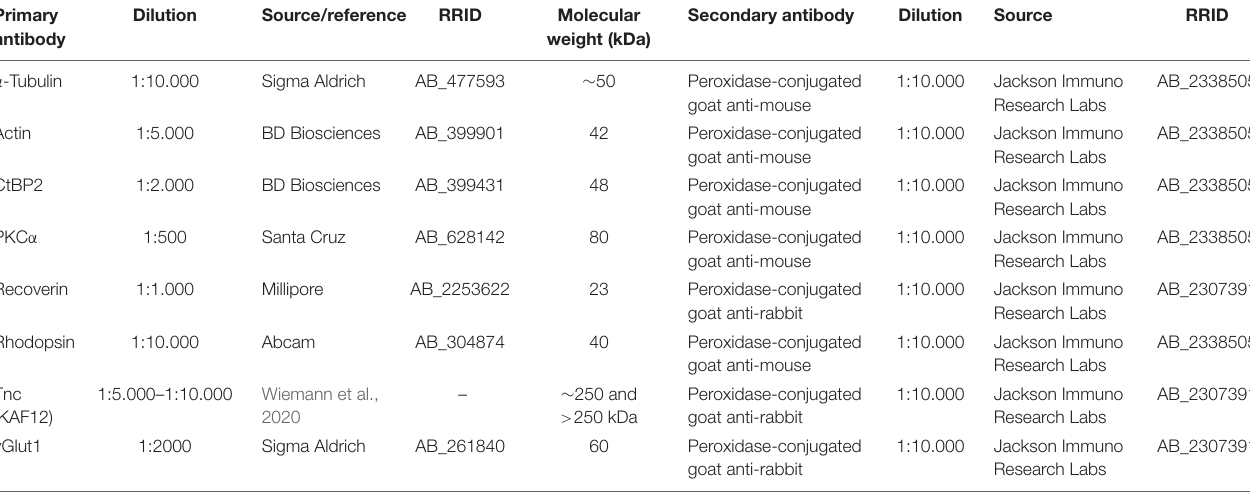
TABLE 2 | Primary and secondary antibodies used for Western blot